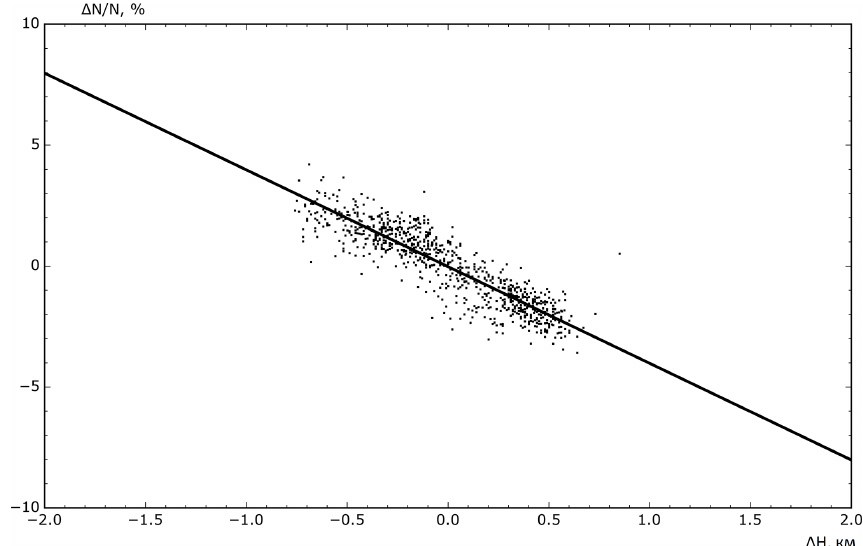
Figure 6. Relationship between (cid:49)N and (cid:49)H (negative temperature effect) for the CARPET-MOSCOW installation determined on the data N 0 of 2019–2020.